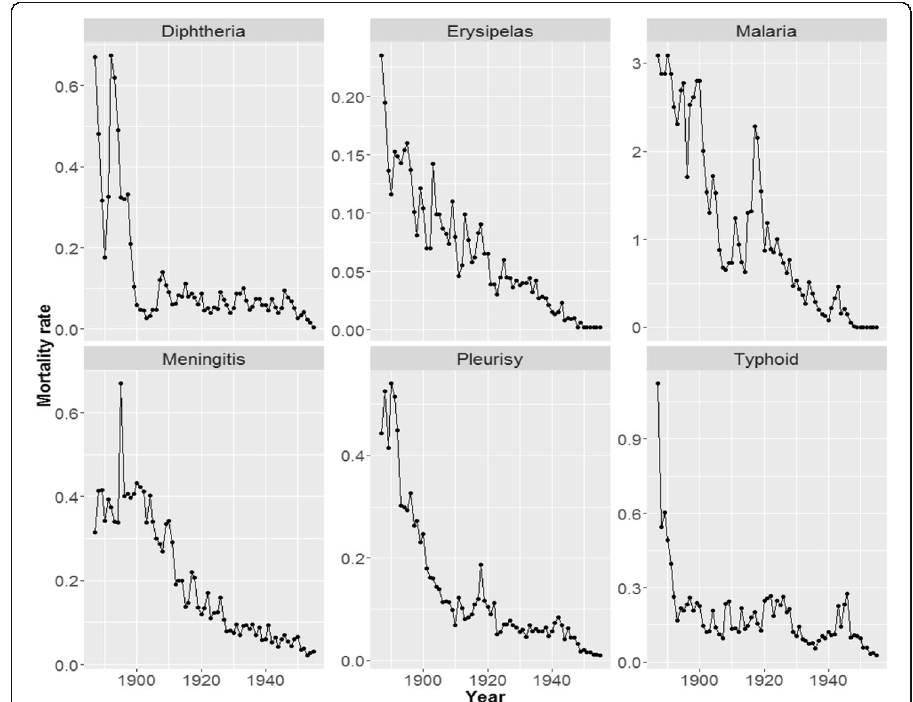
Fig. 3 Some aspects of the epidemiological transition in Sardinia. Note: Mortality rate are expressed as deaths per 1000 average year population. Source : Authors ’ calculation on Istat (1958)